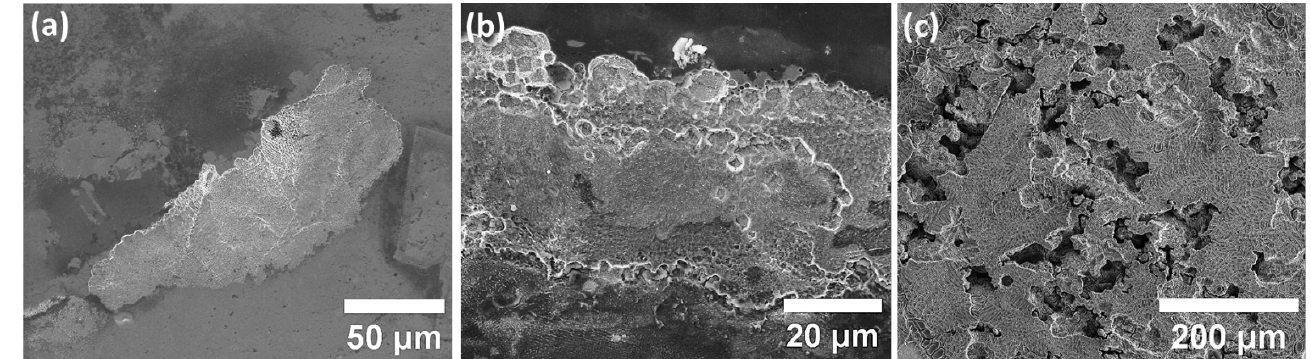
Figure 5. Galvanostatic polarization results in specimens with various energy input densities, for ( a ) as-received polished and ( b ) ground state.